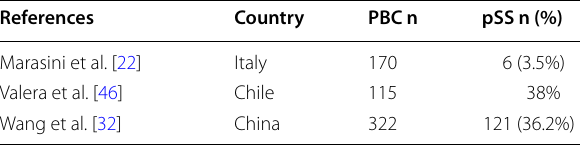
Table 3 Prevalence of pSS in patients with